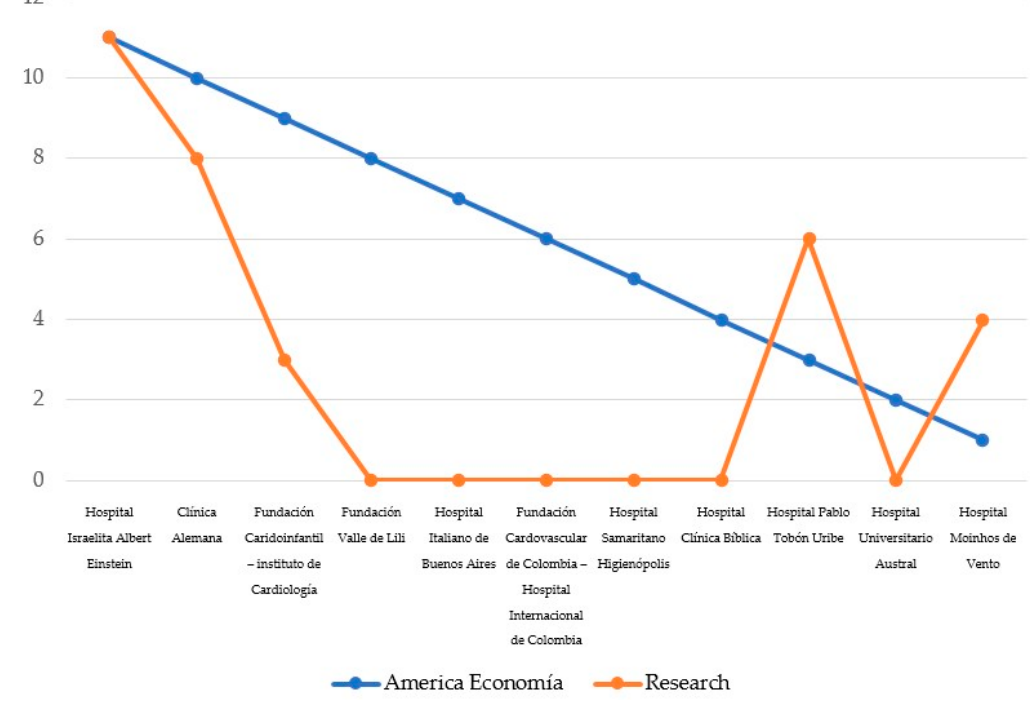
Figure 9. Comparative analysis between the results of the “America Economía Ranking” and results obtained from our study. Own elaboration.